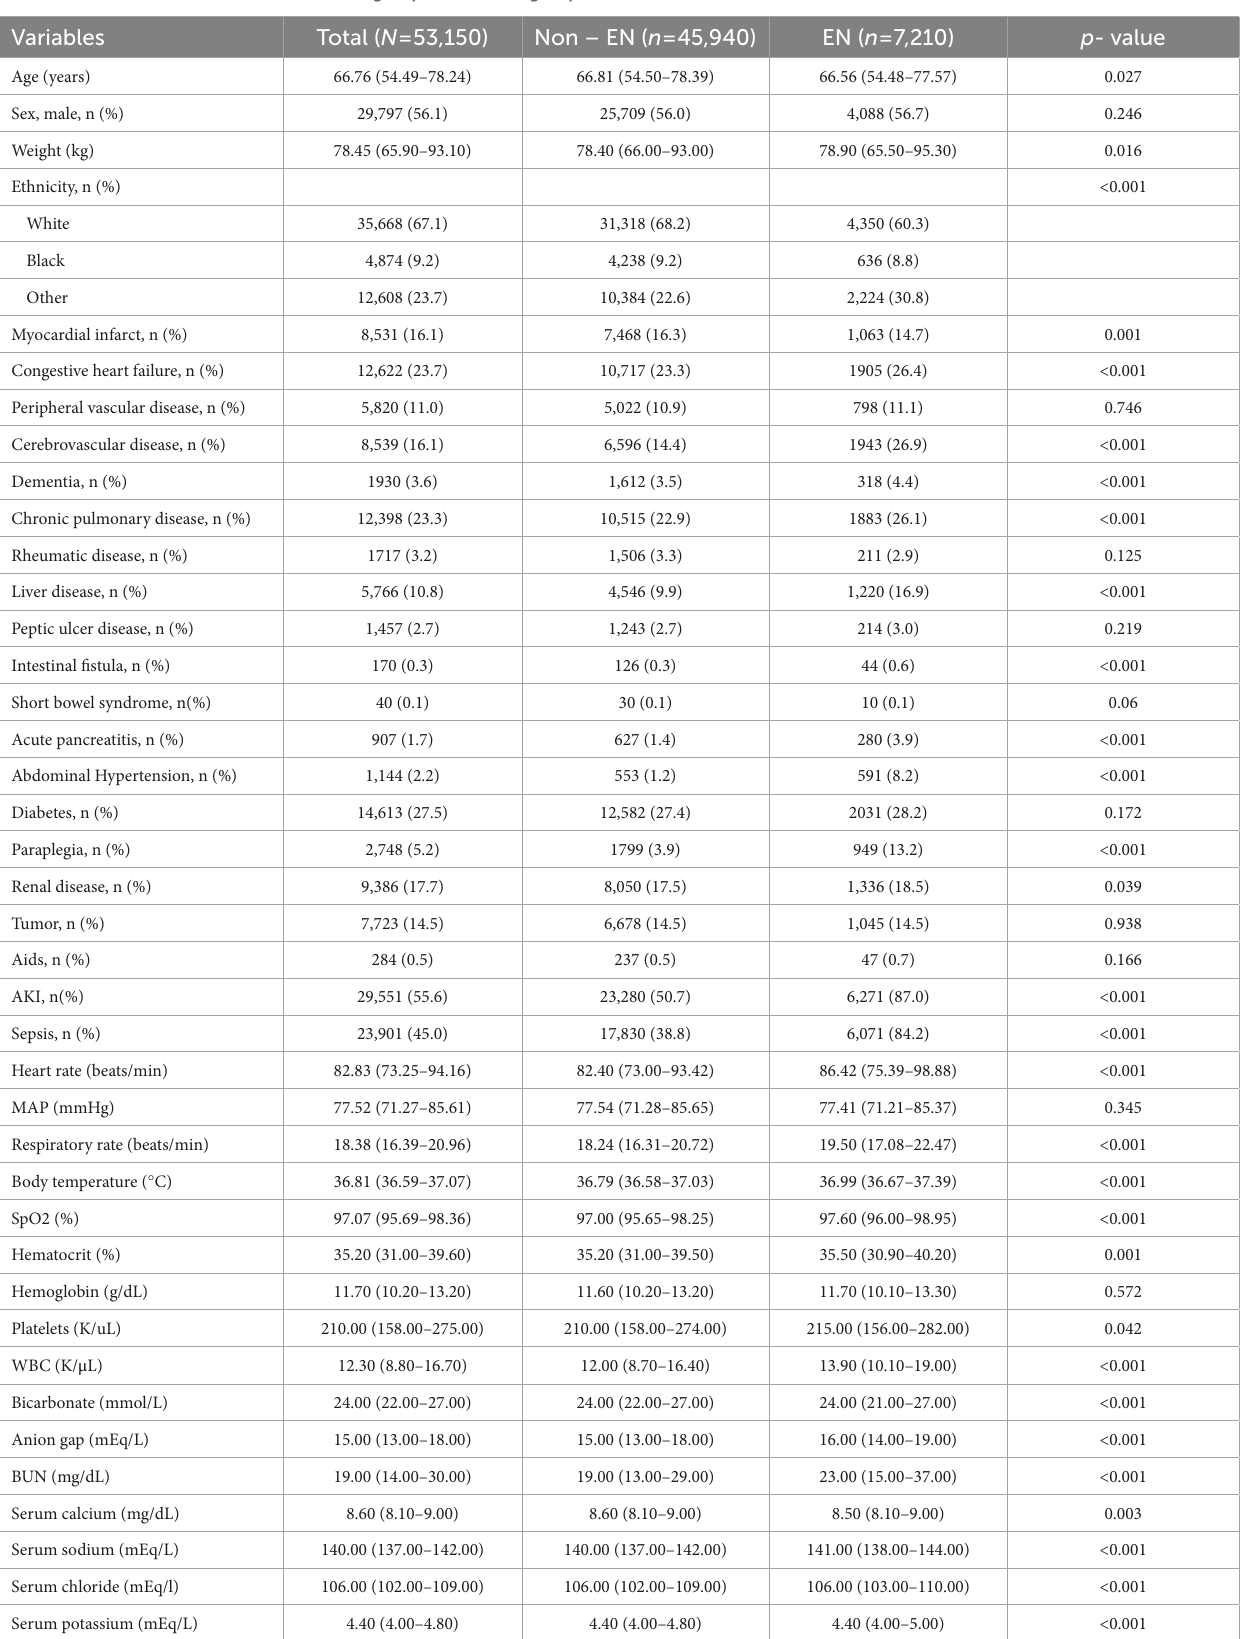
TABLE 1 Baseline characteristics between EN group and non-EN group.